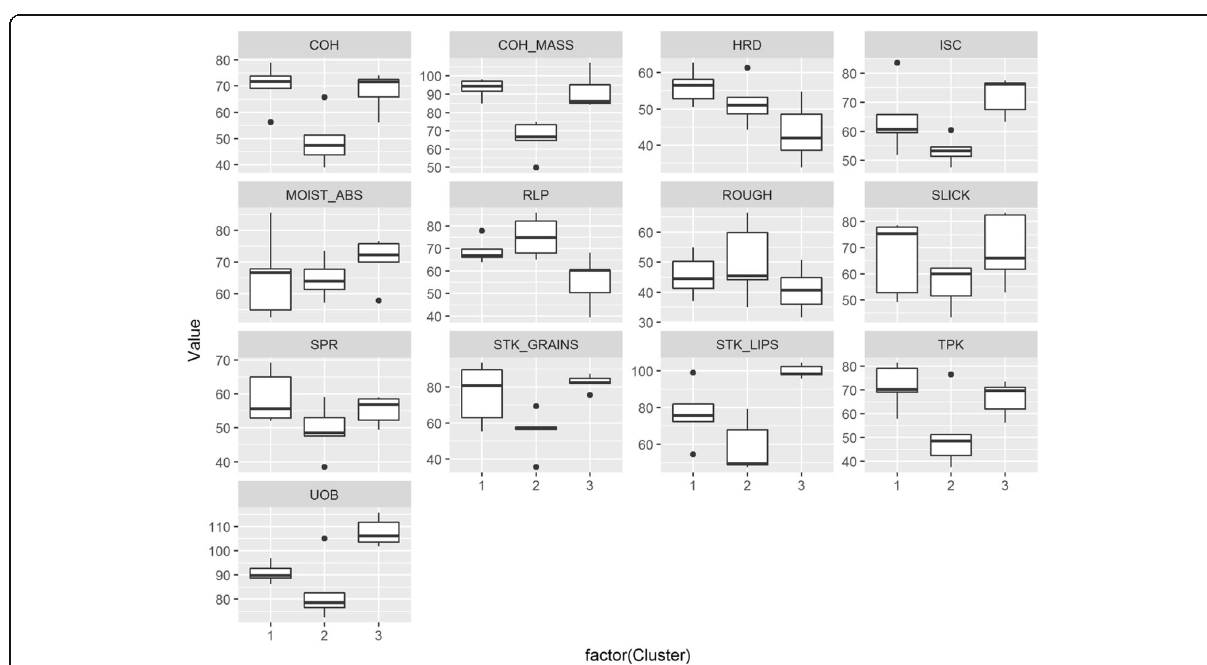
Fig. 5 Box plots comparing the three clusters based on 13 texture attributes evaluated by sensory panelists based on a 150-mm scale. The sensory attributes [13] evaluated were: cohesiveness (COH), cohesiveness of mass (COH_MASS), hardness (HRD), initial starchy coating (ISC), moisture absorption (MOIST_ABS), residual loose particles (RLP), roughness (ROUGH), slickness (SLICK), springiness (SPR), stickiness between grains (STK_GRAINS), stickiness to the lips (STK_LIPS), toothpack (TPK), uniformity of bite (UOB)